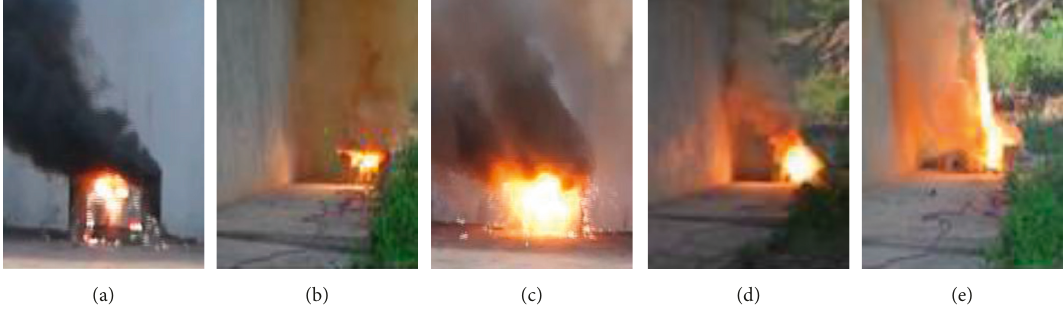
Figure 2: The combustion processes of thermite. (a) 1#. (b) 2#. (c) 3#. (d) 4#. (e) 5#.